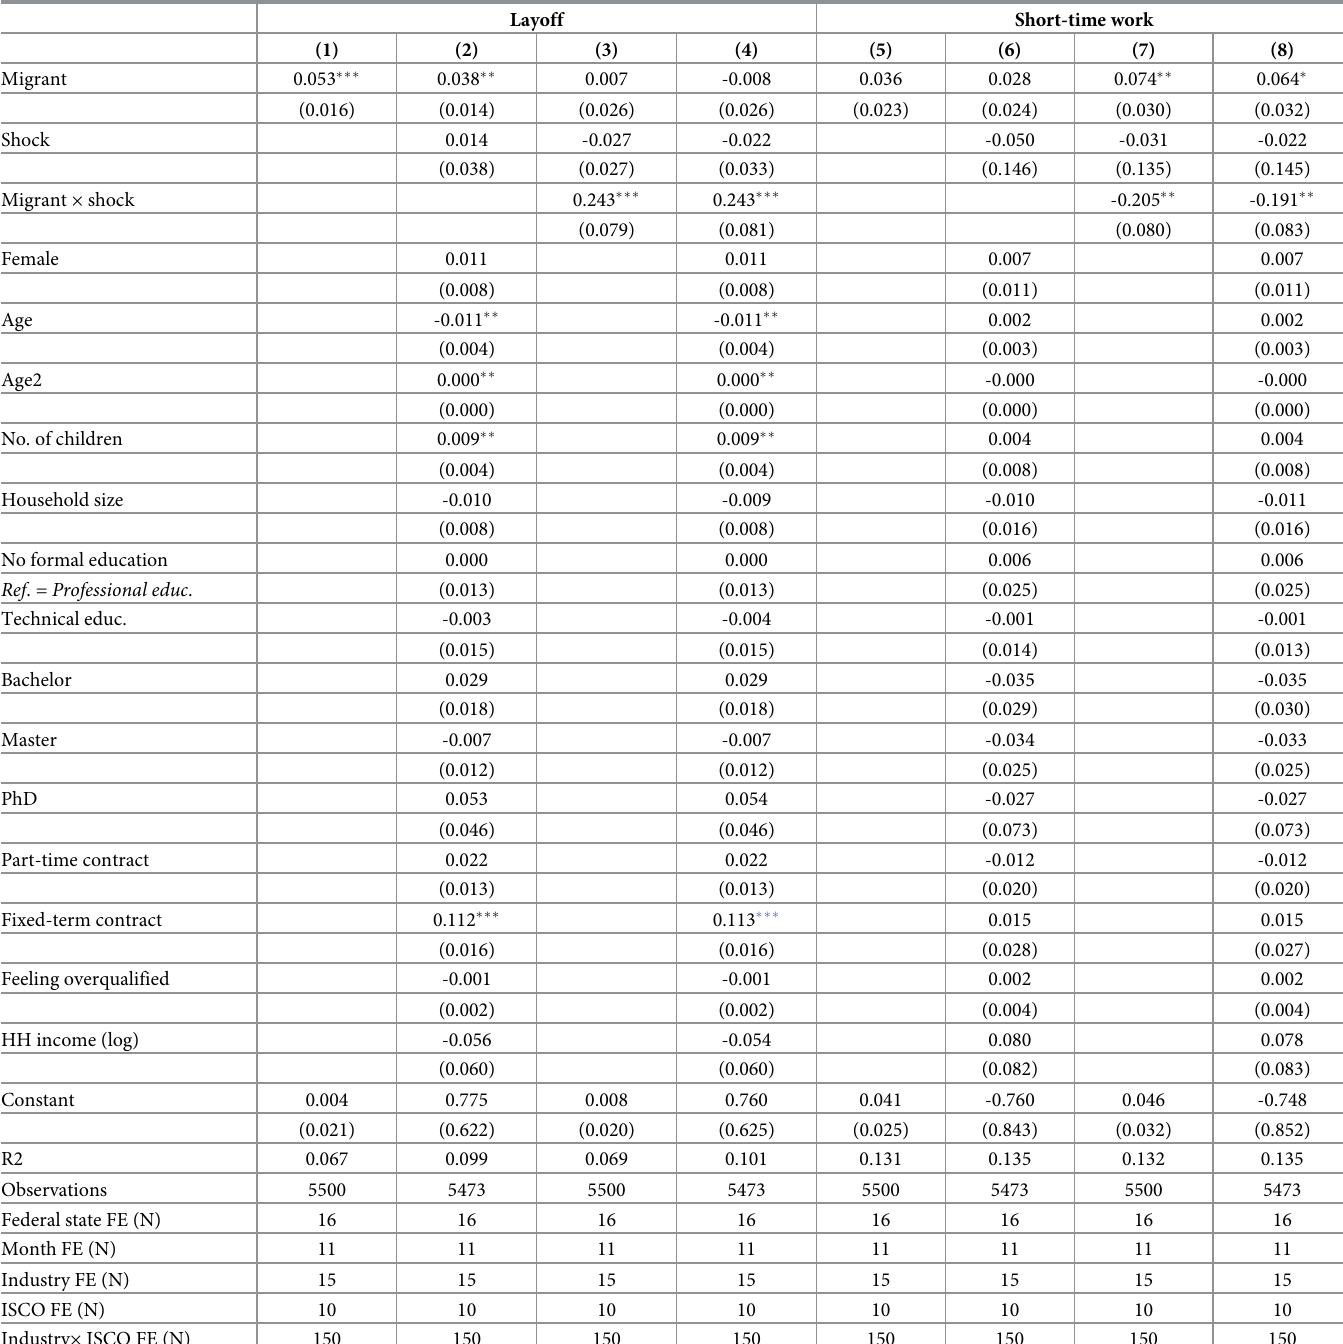
Table 1. Heterogeneous firm responses to the economic